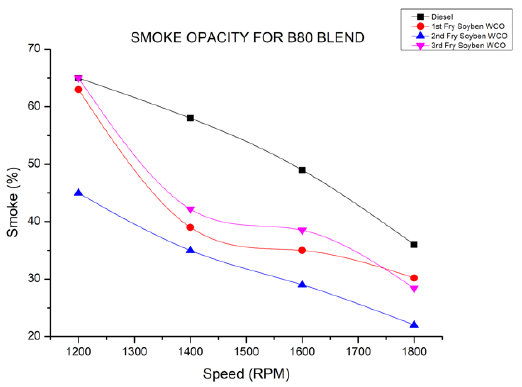
Figure 11. Smoke emission of different fry oils (B80 blend) at different rpm.